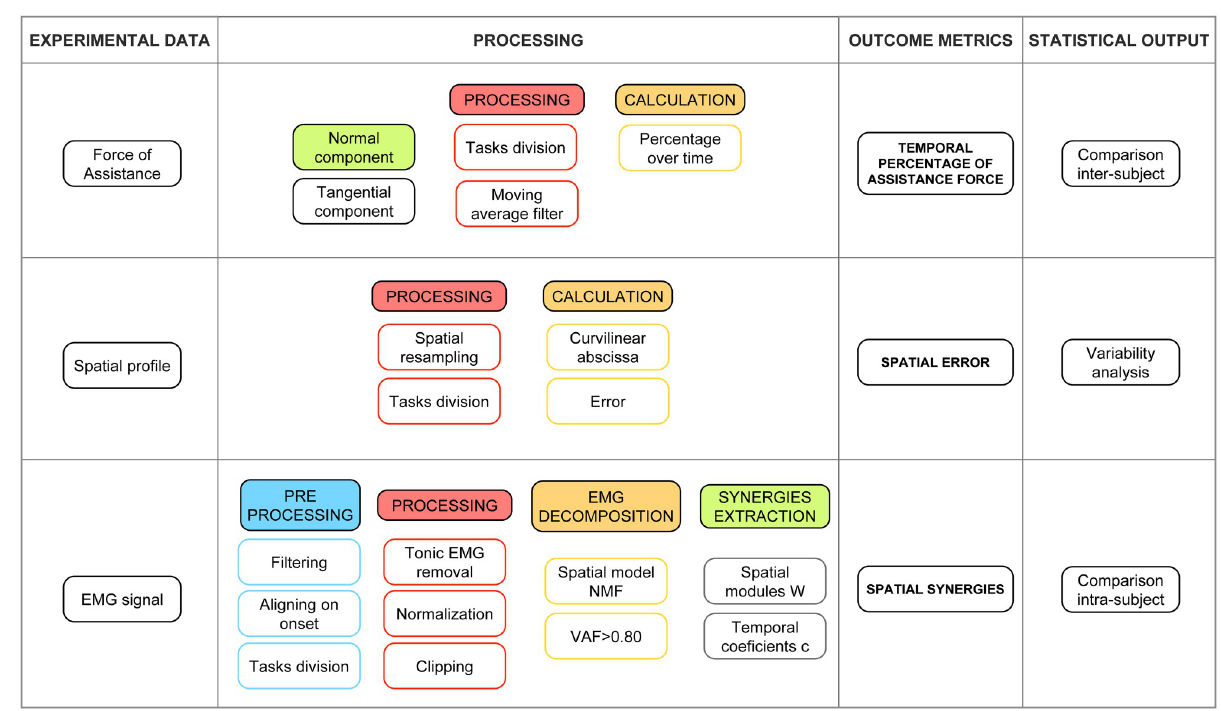
Fig 4. A detailed scheme of the 3 output variables is shown. 1) percentage of assistance force; 2) Spatial error in Free and Assisted modes with respect to the Reference Trajectories; 3) EMG data analysis and synergy extraction. EMG data were first aligned, filtered and segmented into sub-tasks. Then, EMG data underwent removal of tonic components, and each channel was normalized to the maximum EMG found in all trials for that channel. Lastly, negative phasic EMG data were clipped to 0. Then, synergies were extracted with the NMF algorithm; the analysis of human-robot interaction was conducted by comparing spatial synergies of the Free and Assisted modes, for each exercise separately, with an intra-subject analysis.